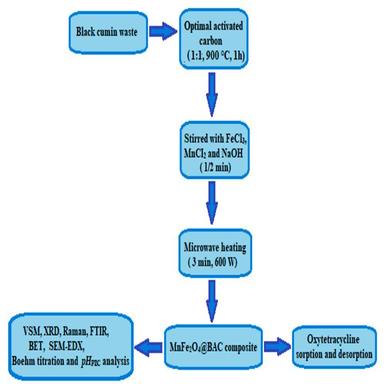
Systematic representation of the study.